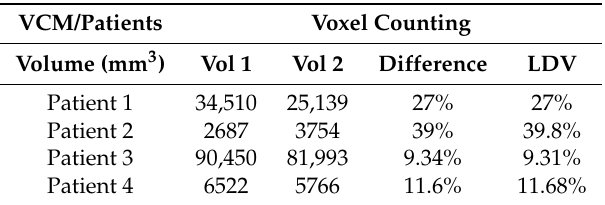
Table 1. Voxel counting applied on the local dissimilarity volume (LDV). VCM: volume calculation method.